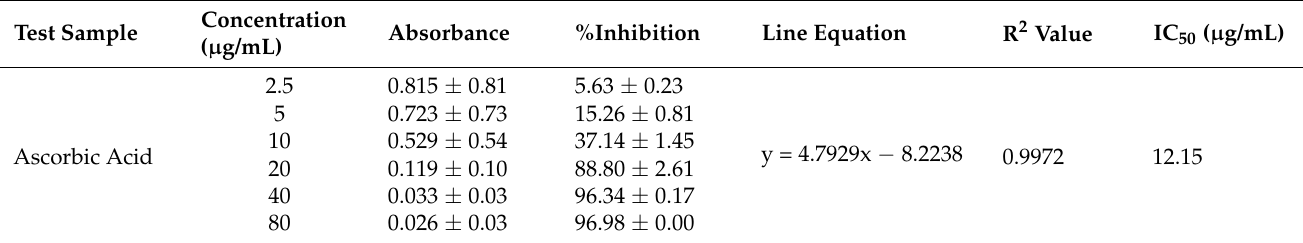
Table 4. Activity of Ascorbic Acid in DPPH scavenging assay.